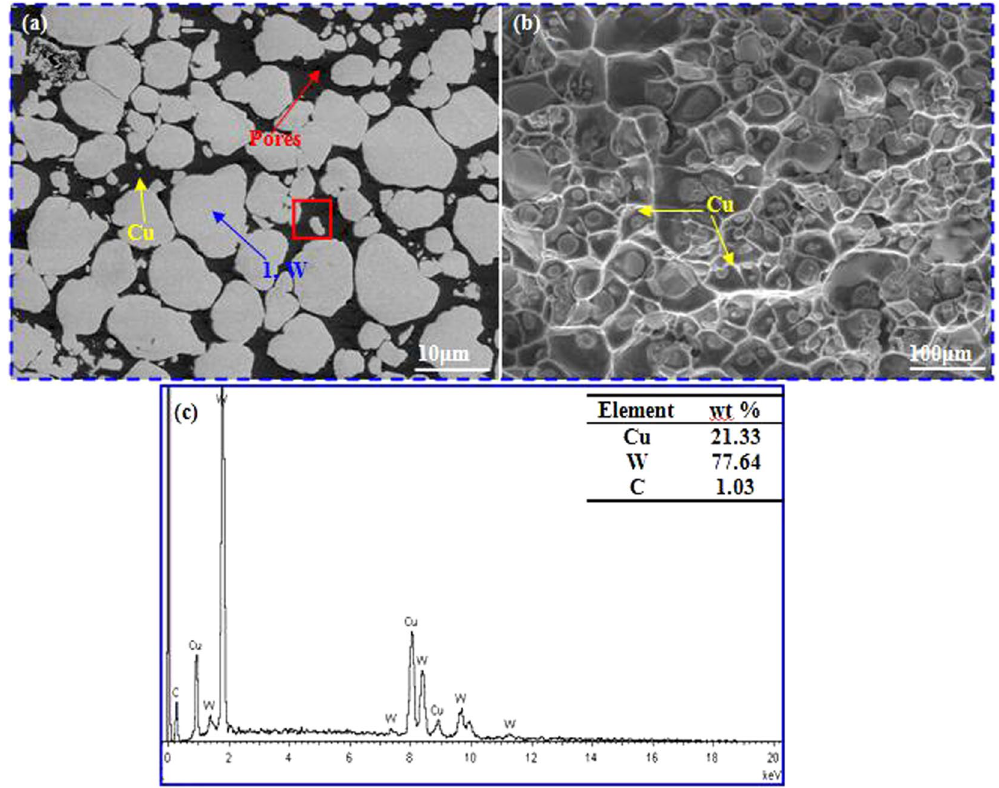
Figure 2. SEM images showing microstructures of Cu@Gr/WCu composites. ( a ) polished and etched cross- section; ( b ) fracture surfaces, and ( c ) EDS result of red rectangle in Fig. 2(a).